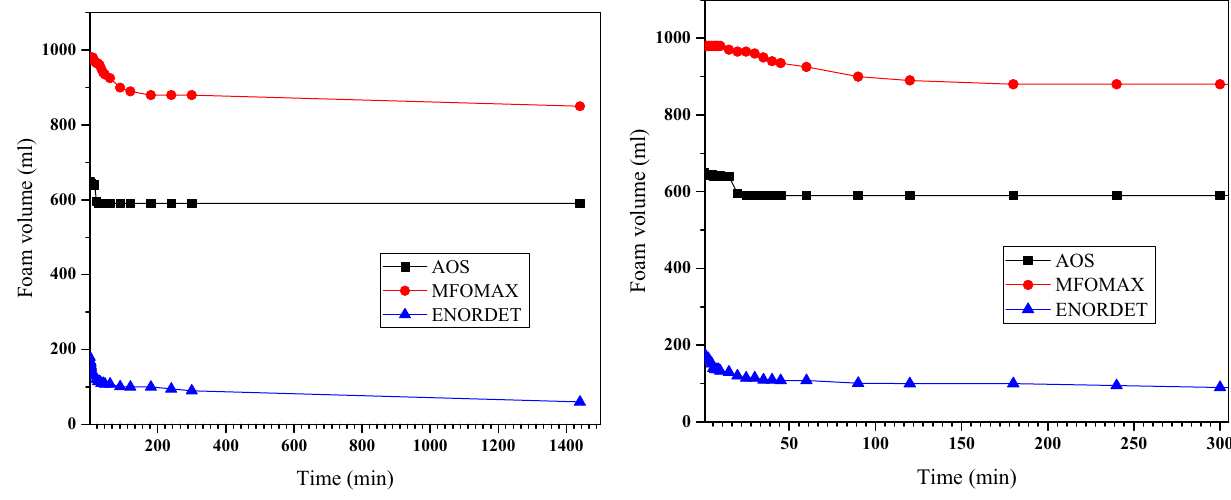
Fig. 4 The bulk foam stability tests for foam stability of the three selected surfactants, (left: complete test data, right: first 300 min of test